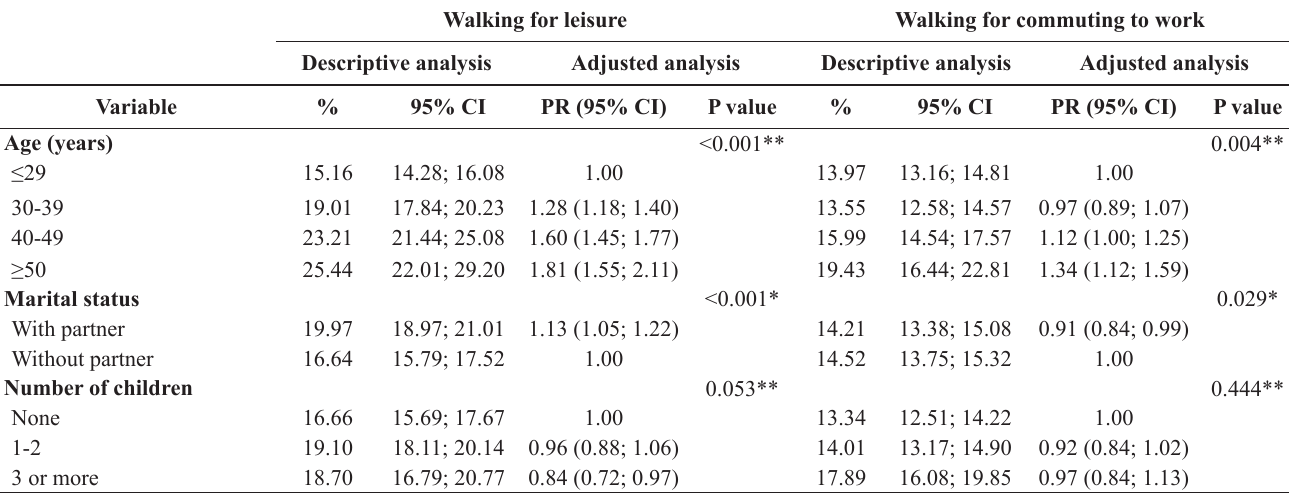
Table 3. Descriptive and adjusted analysis of habitual practice walking for leisure and commuting to work among Brazilian female industry workers. Brazil,